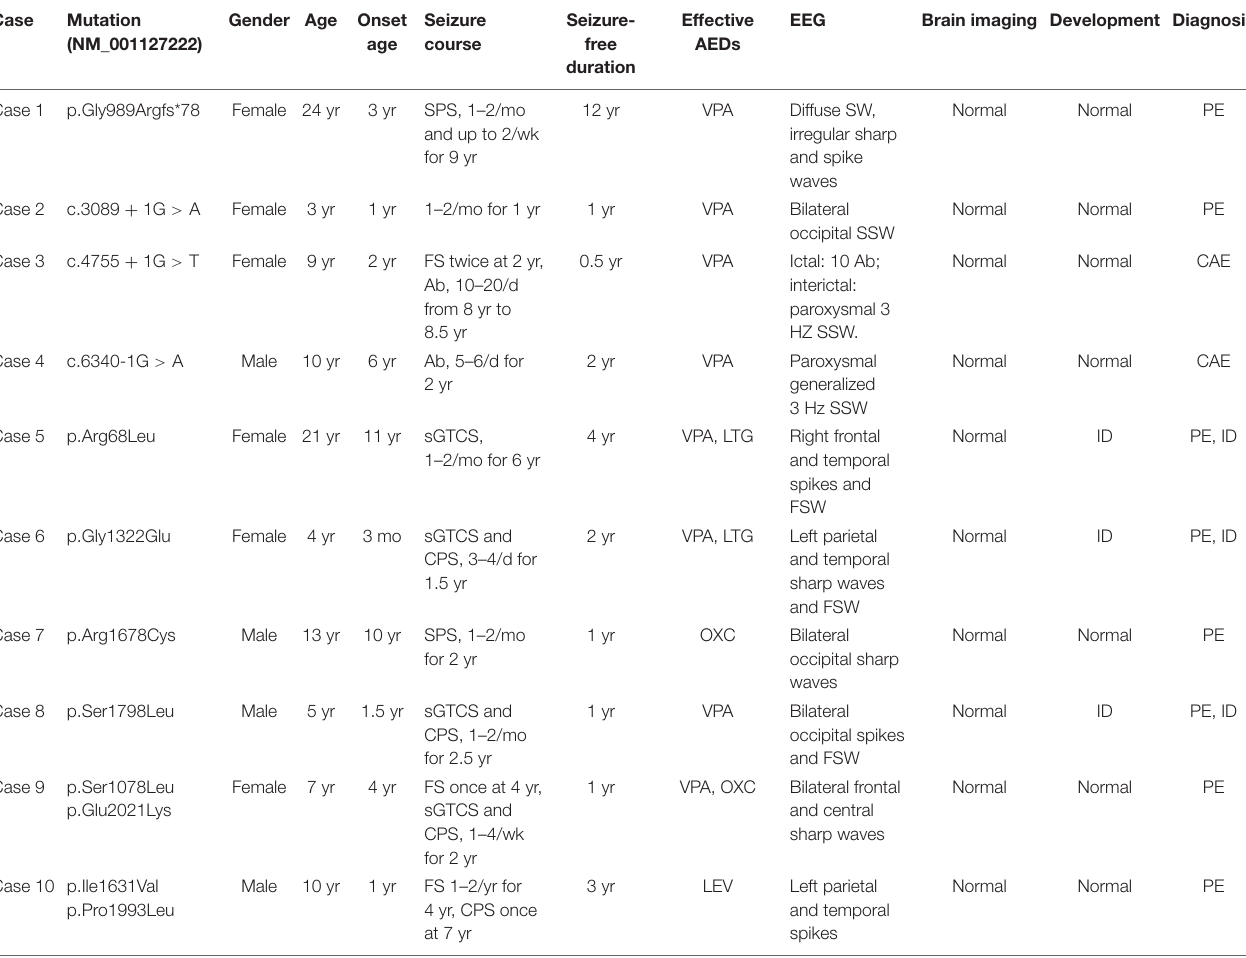
TABLE 1 | Clinical feature of the individuals with CACNA1A